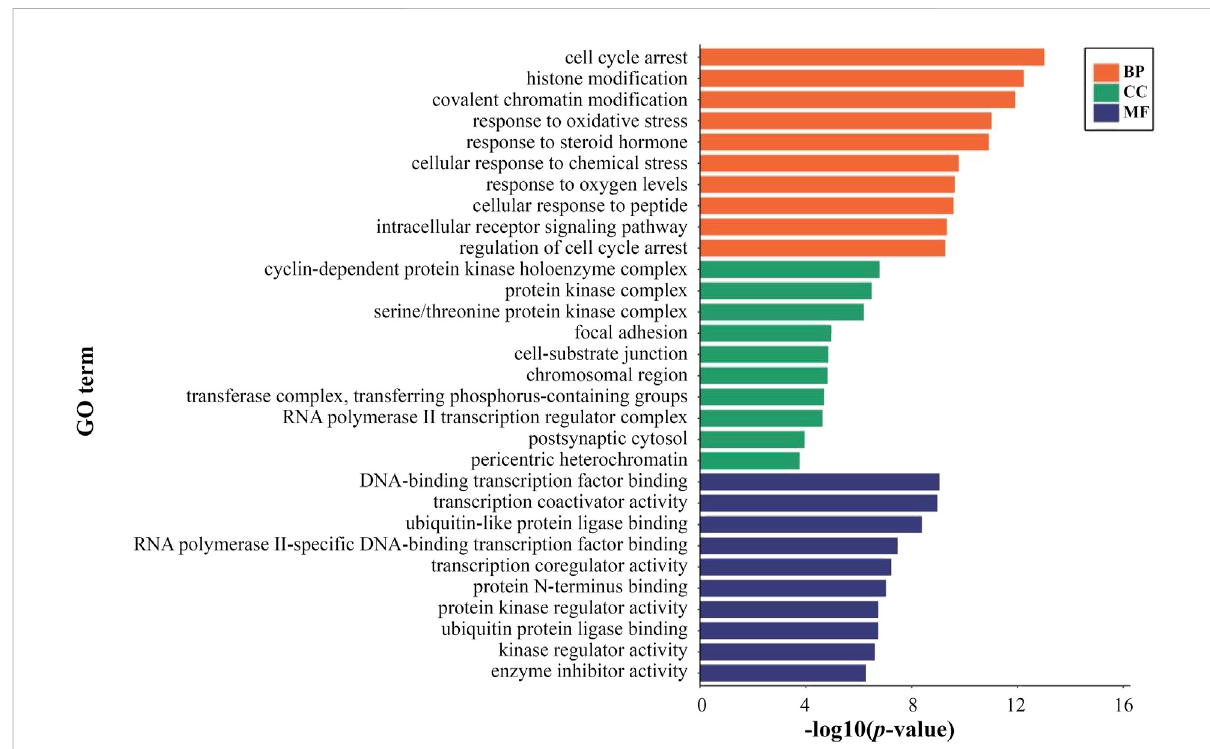
FIGURE 3 The top 10 signi fi cant terms of GO functional enrichment analysis of DEGs on PSCE. Abscissa: log ( p -value), ordinate: GO terms, including biological process (orange), molecular function (green), cellular component (blue). The length of the column indicated the signi fi cant -log ( p -value) of this GO term. The larger the -log ( p -value) was, the more signi fi cant the enrichment